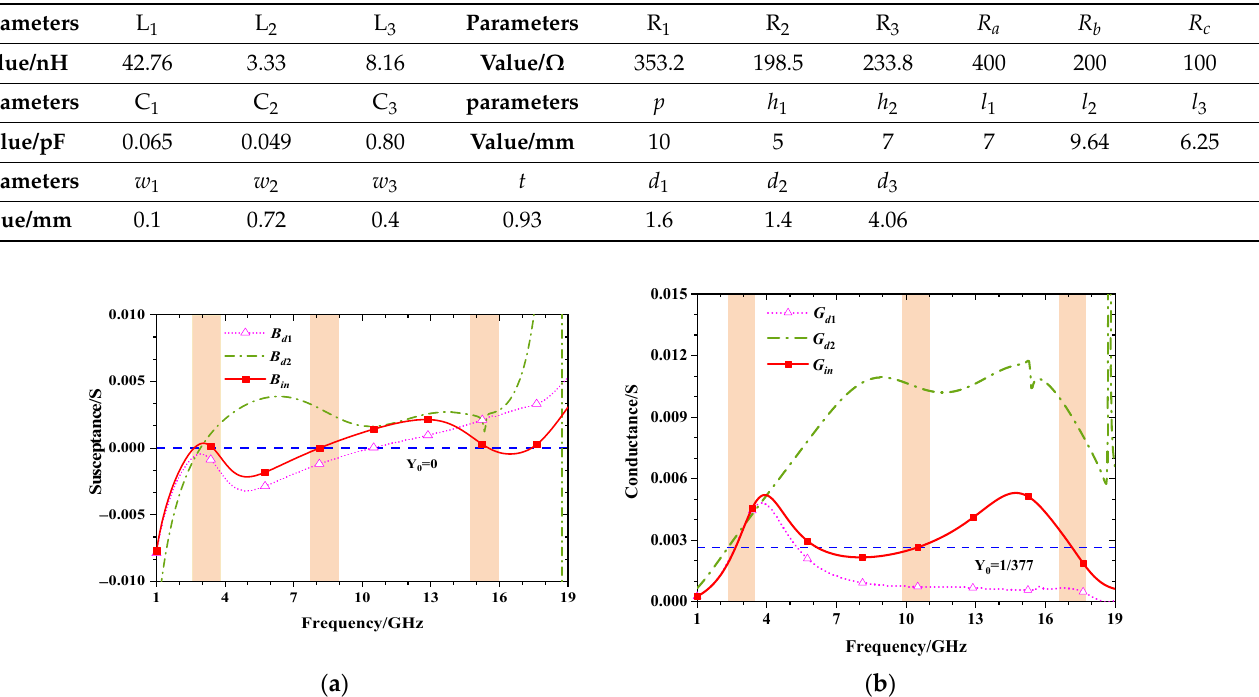
Figure 3. Comparison of reflective coefficients simulated by CST and calculated by ECM.